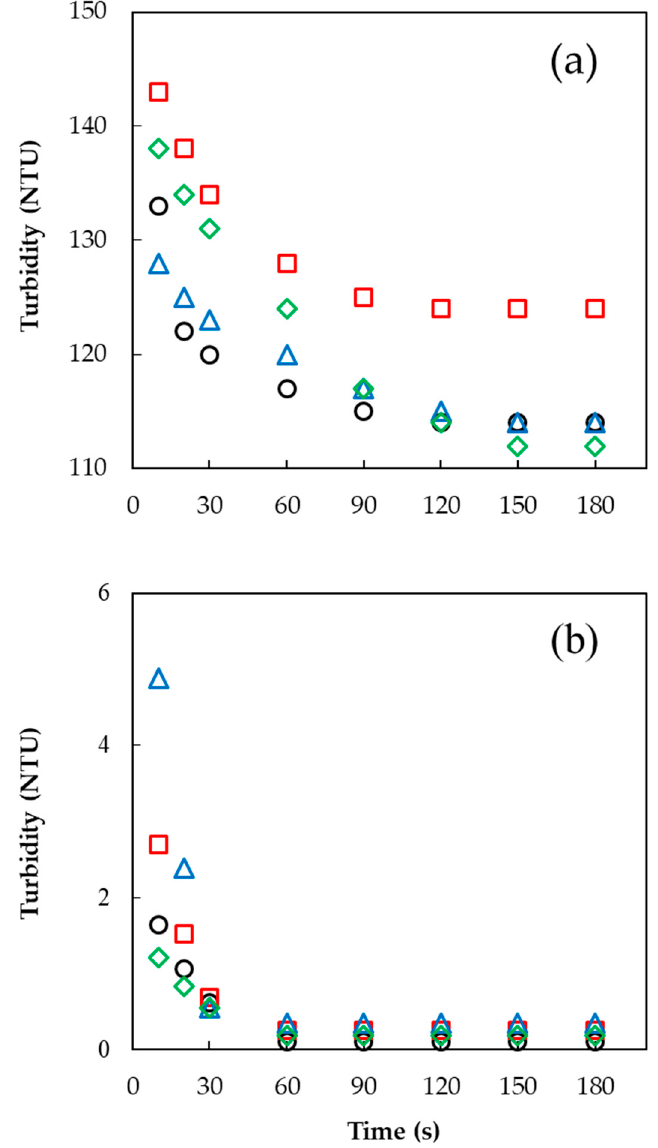
Figure 2. Turbidity value (NTU) of ( a ) GG and ( b ) CMC agglomerates with different sugar binders: ( ○ ) glucose, ( □ ) sucrose, ( △ ) lactose, and ( ◇ ) sorbitol.